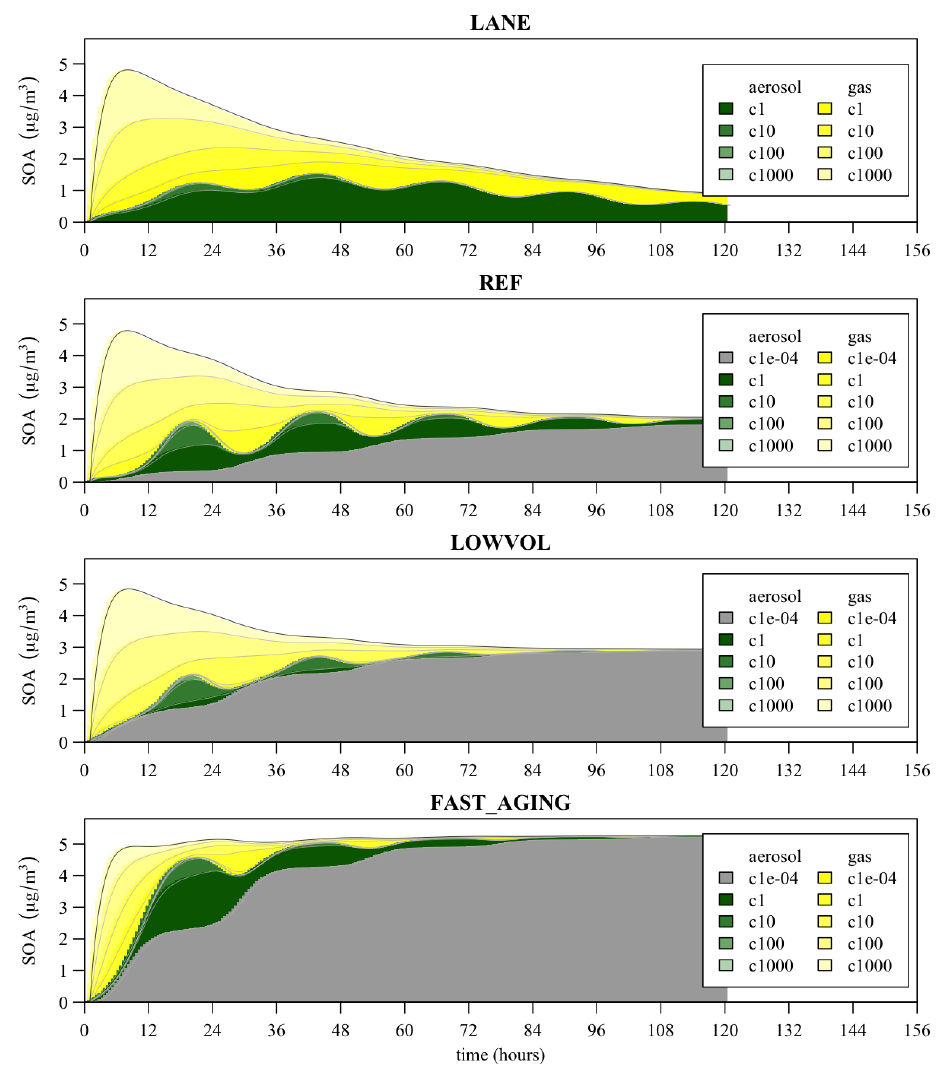
Figure A2. Evolution of mass distribution in the particle and vapor phases in the box model simulations for the different